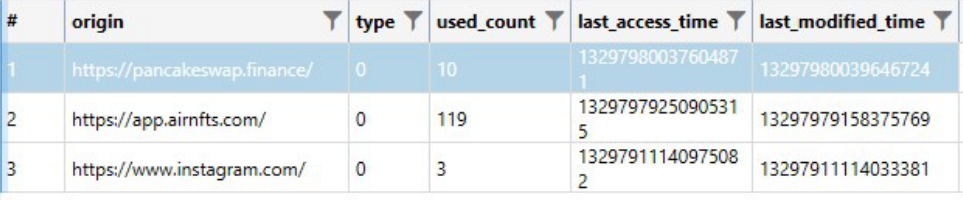
Figure 33. Count of how many times the web services/websites have been accessed by the